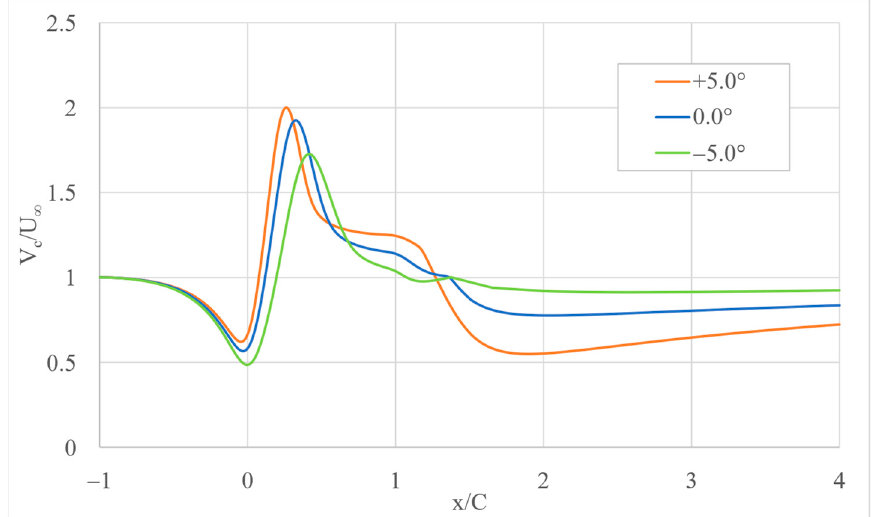
Figure 11. Center line normalized velocity as a function of pitch angle ( U ∞ = 3 m/s, 30 cm gap).